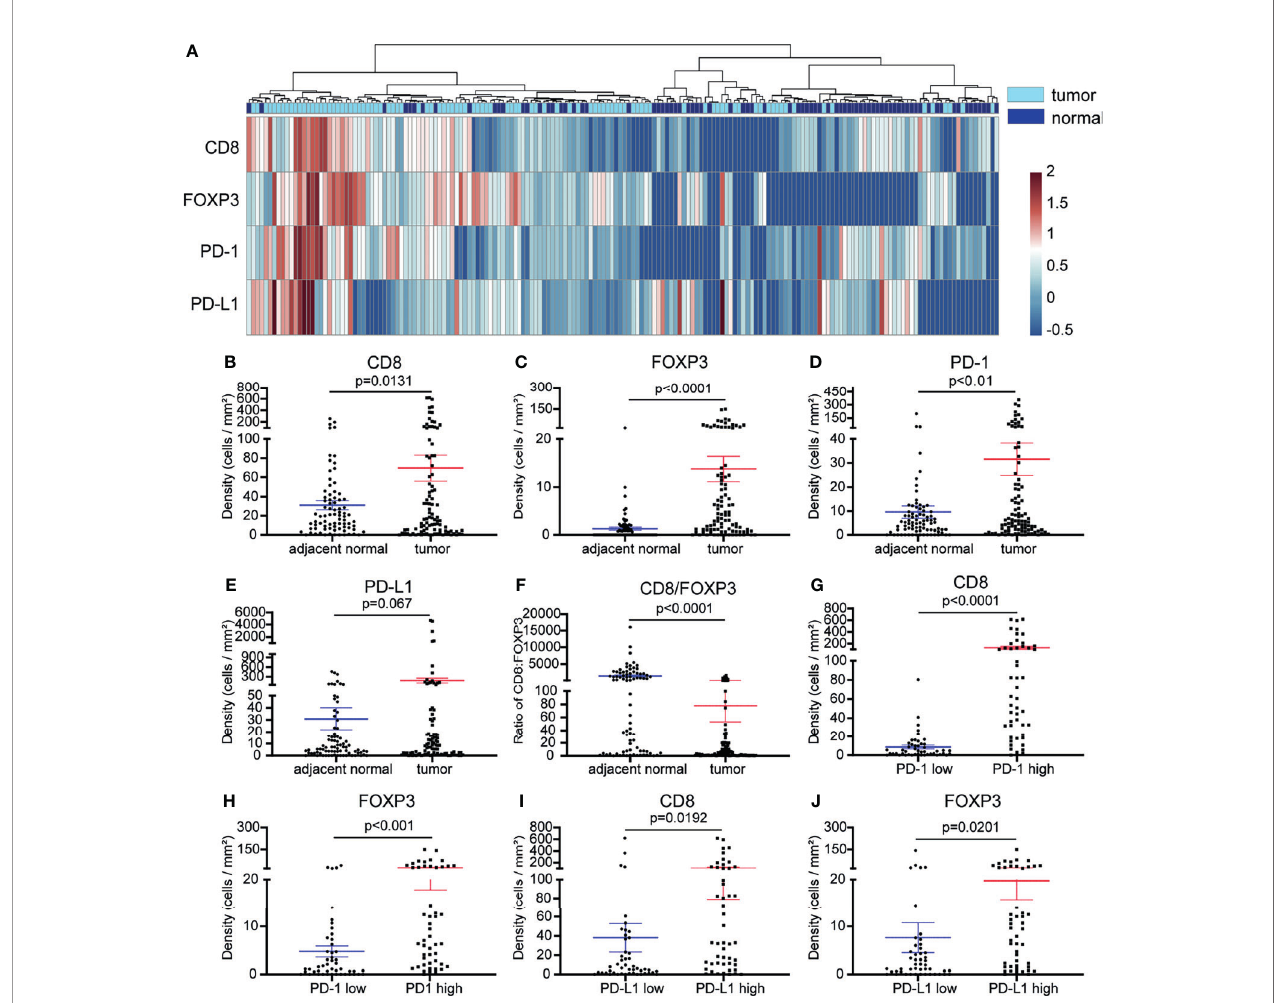
FIGURE 2 | Comparison of the cell densities of CD8+ T cells, FOXP3+ cells, PD-1+ cells and PD-L1+ cells in tumor and adjacent normal tissues and the relationships between these markers. (A) Heatmap representation of the hierarchical clustering showing the density levels of CD8+, FOXP3+, PD-1+ and PD-L1+ cells and a dendrogram of the results of the unsupervised hierarchical clustering of tumors and adjacent normal samples. (B – D) Compared with those in adjacent normal samples, the densities of CD8+ cells, FOXP3+ Treg cells, and PD-1+ cells in tumor samples were signi fi cantly increased (p <0.01-0.0001). (E) Compared with that in adjacent normal tissues, the expression of PD-L1 was inclined to increase in tumor tissues (p =0.067). (F) Compared with that in adjacent normal tissues, the ratio of CD8/FOXP3 in tumor tissues was signi fi cantly reduced (p <0.0001). (G – J) The CD8+ T cell and FOXP3+ Treg cell densities were signi fi cantly higher in NSCLC tissues with high PD-1+ cell density (G, H) and in the PD-L1 high expression group (I, J) (p < 0.05-0.0001). Error bars represent the